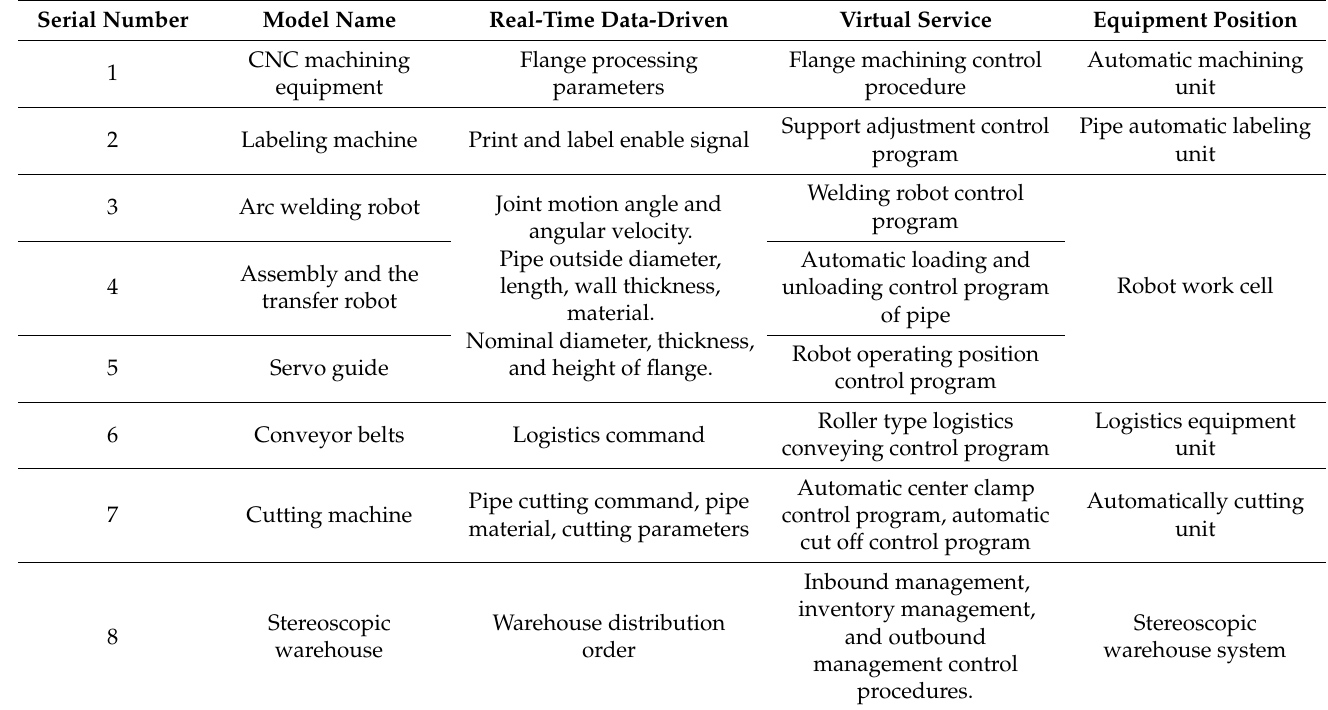
Table 2. Pipe machining production equipment driver data and virtual